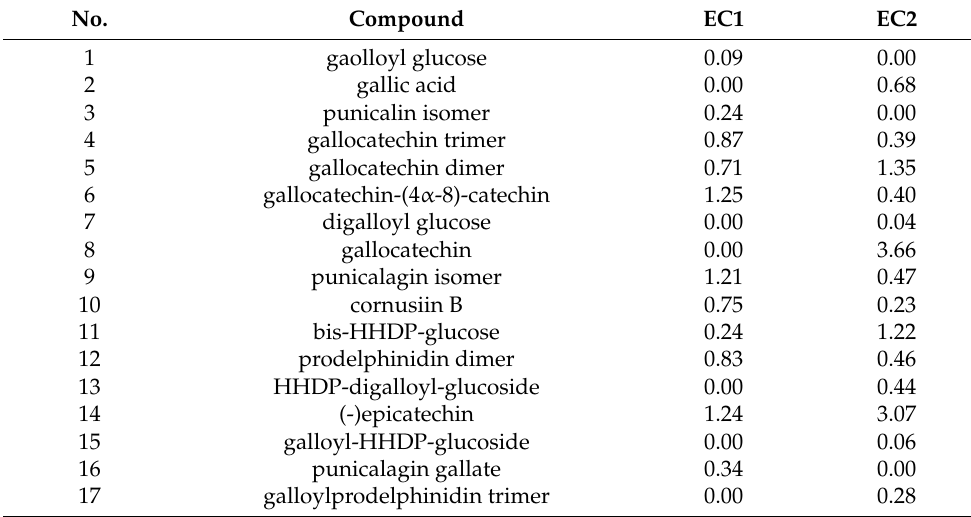
Table 2. Percentage contained extracts from Cistus incanus L. (EC1 and EC2).